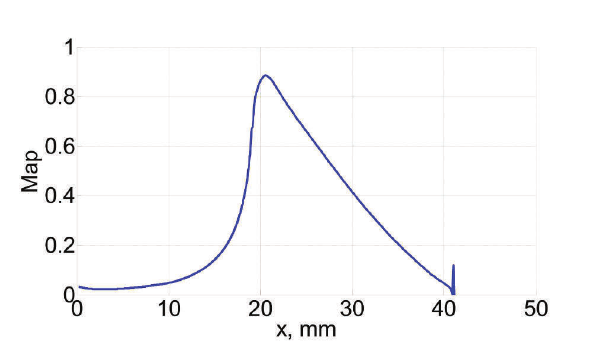
Figure 7. Graph of average particle Mach number vs. dis- tance along the nozzle axis.